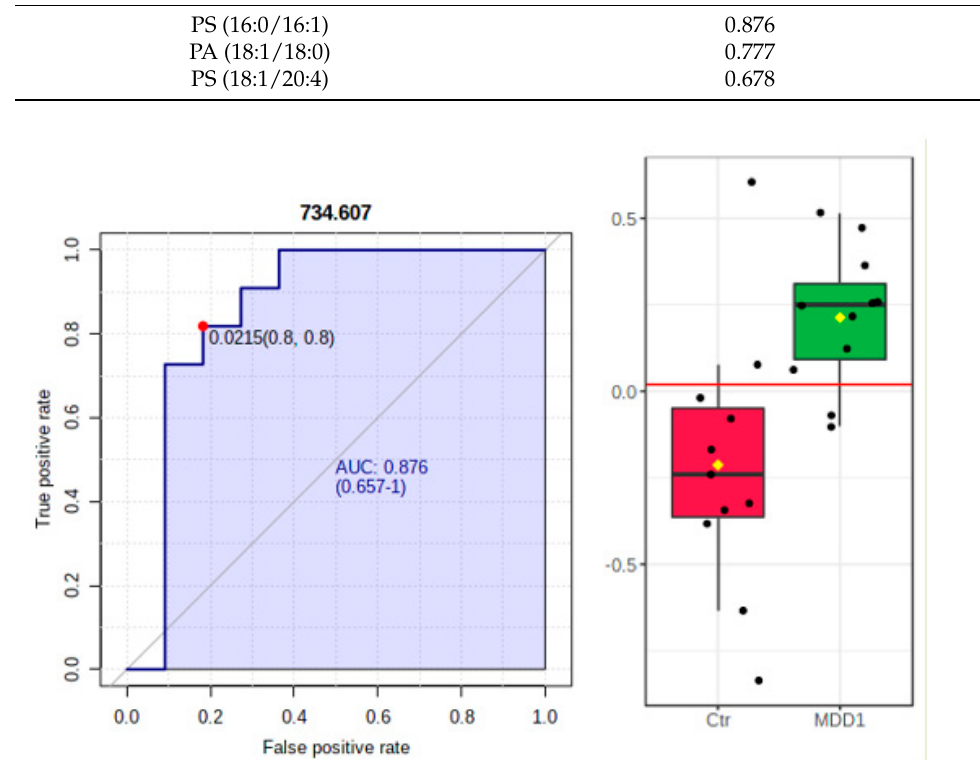
Figure 2. ROC analysis based on area under ROC curve (AUROC) >0.8 for PS (16:0/16:1) ( m/z = 734.607). The mean values are higher in the MDD1group (before treatment). 2.3. Metabolomic Profiles of Patients, before and after Treatment (MDD1 vs. MDD2) Multivariate statistical analyses (PCA, PLS-DA, m/z values with VIP > 0.2 on all five components) were performed and are presented in Figure 3 and Table 4, respectively.